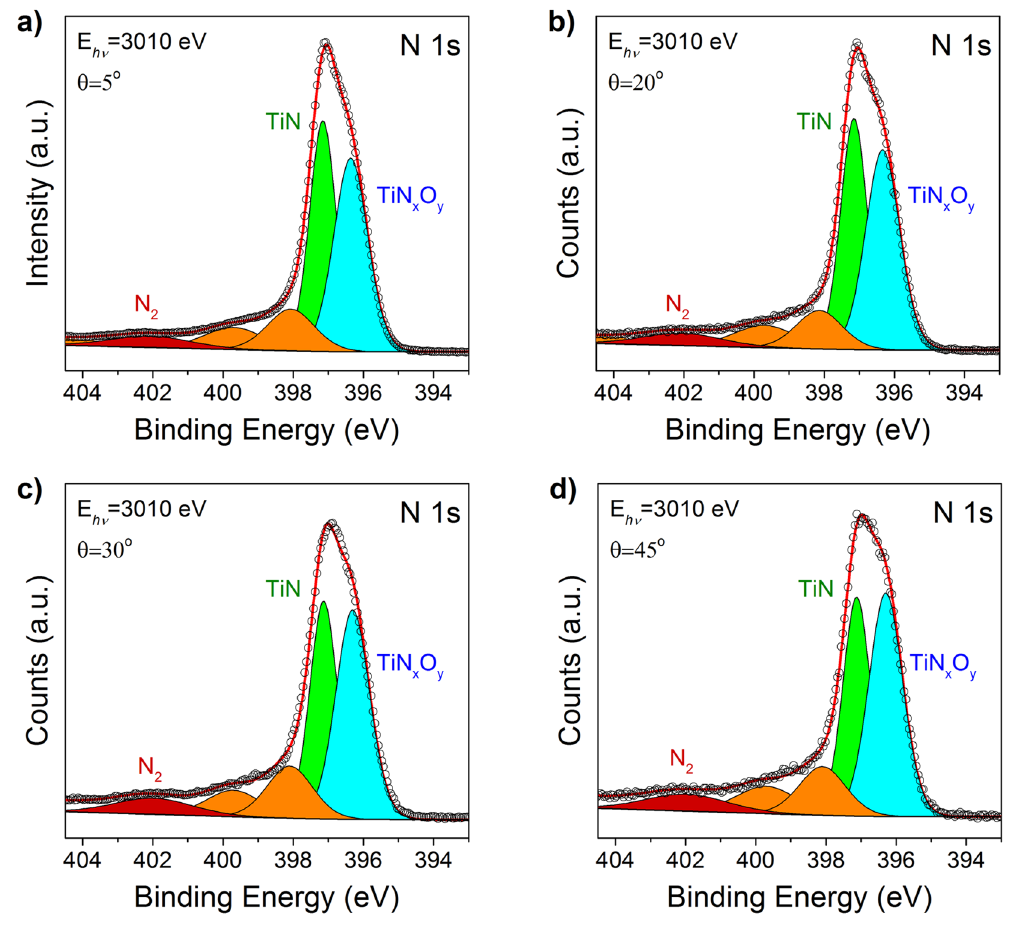
Figure 1. Experimental and fitted N1s photoelectron spectra from TiN/Al 2 O 3 /Si stack measured at an excitation photon energy of 3010 eV and different electron emission angles: ( a ) 5°; ( b ) 20°; ( c ) 30° and ( d ) 45°.